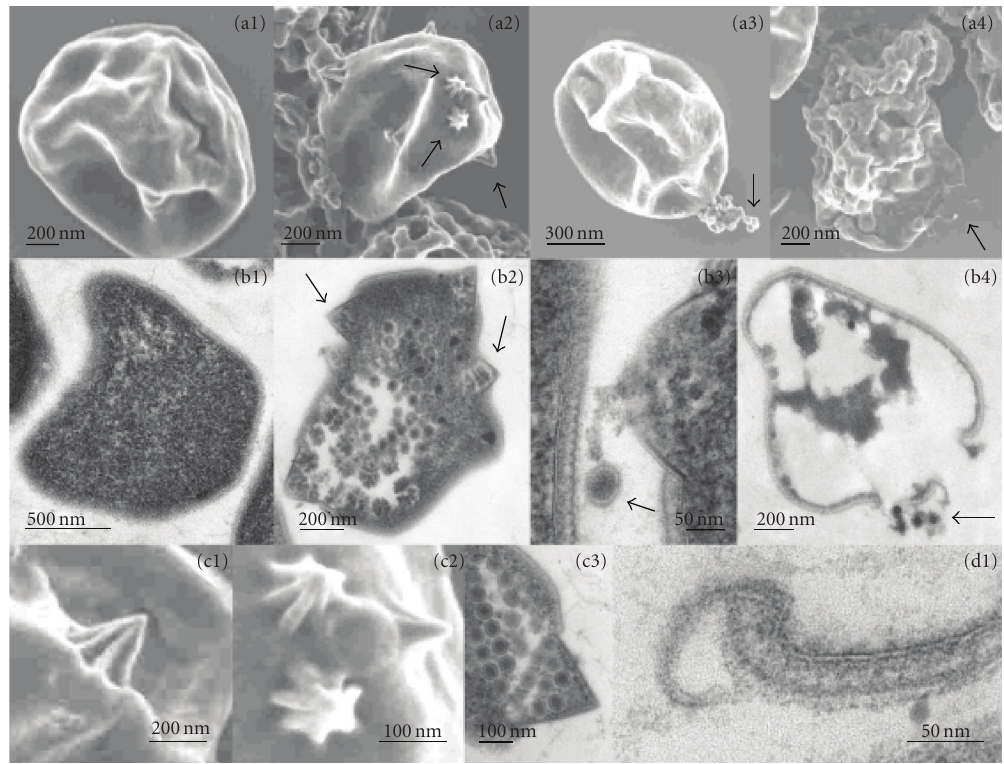
Figure 2: SEM images (row a) and corresponding TEM images (row b) of S. solfataricus cells show di ff erent stages of infection. (a1 and b1) Noninfected cells. (a2 and b2) Cells infected with STIV displaying membrane protrusions (thin arrows). (a3 and b3) Lysing cells releasing virus (thin arrows) and cell contents. (a4 and b4) Empty cells showing S-layer and broken membrane fragments (thin arrows). Pyramid-like structures from STIV-infected cells observed by SEM (c1 and c2) and TEM (c3) are also shown. (d1) TEM image of broken membrane and S-layer after cell lysis. Scale bars are indicated (courtesy of Mark